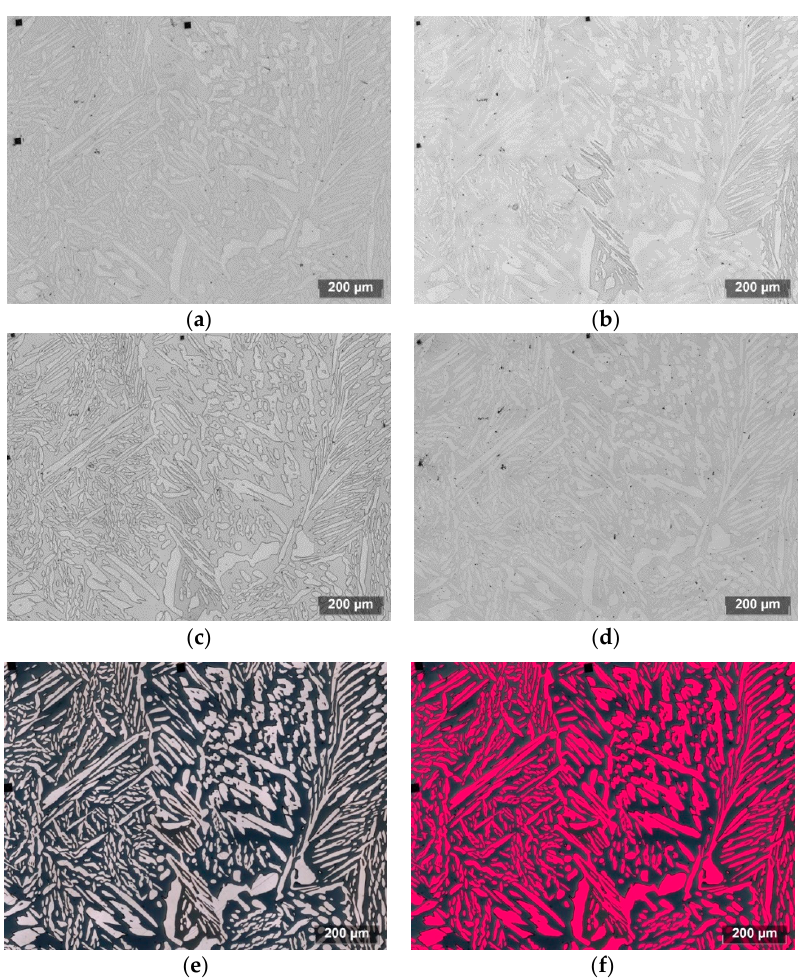
Figure 1. Microstructure of Steel 1 quenched from 1200 °C after electrolytical etching using NaOH ( a ), chemical etching using Glyceregia ( b ), Carpenter ( c ), Murakami’s ( d ), and Beraha’s ( e ) etchant solutions and austenite automatic identification after using Beraha’s etchant ( f ).